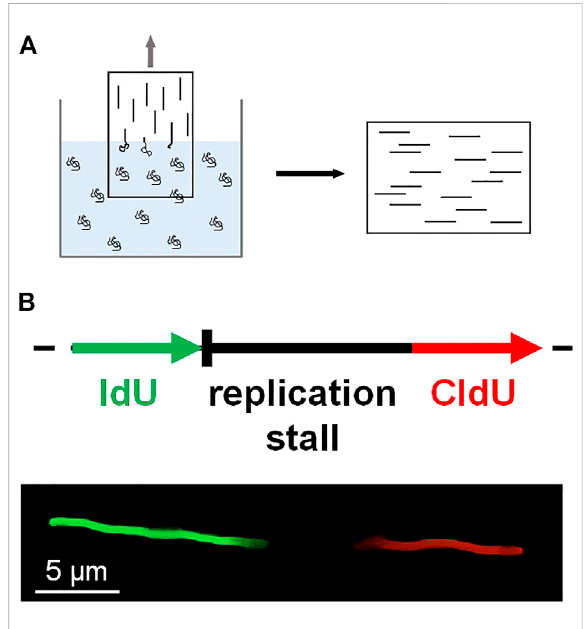
FIGURE 4 DNA combing. (A) A coverslip coated with positively charged polymers is slowly pulled out of a solution containing DNA molecules. DNA becomes stretched at the air-water interface and sticks to the coverslip surface. The stretched DNA molecules are stained and fl uorescently imaged. (B) Schematic of DNA fi ber assay based onDNA combing. During DNA replication, IdU (green) is incorporated into DNA before replication fork stalling, whereas CldU (red) is treated after fork stalling. The length of the nascent strand before fork stalling is estimated by the length of the IdU